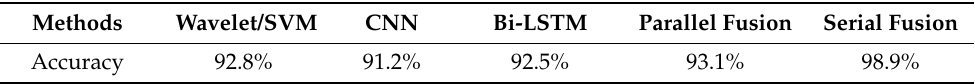
Table 3. Classification accuracy of different methods without noise.